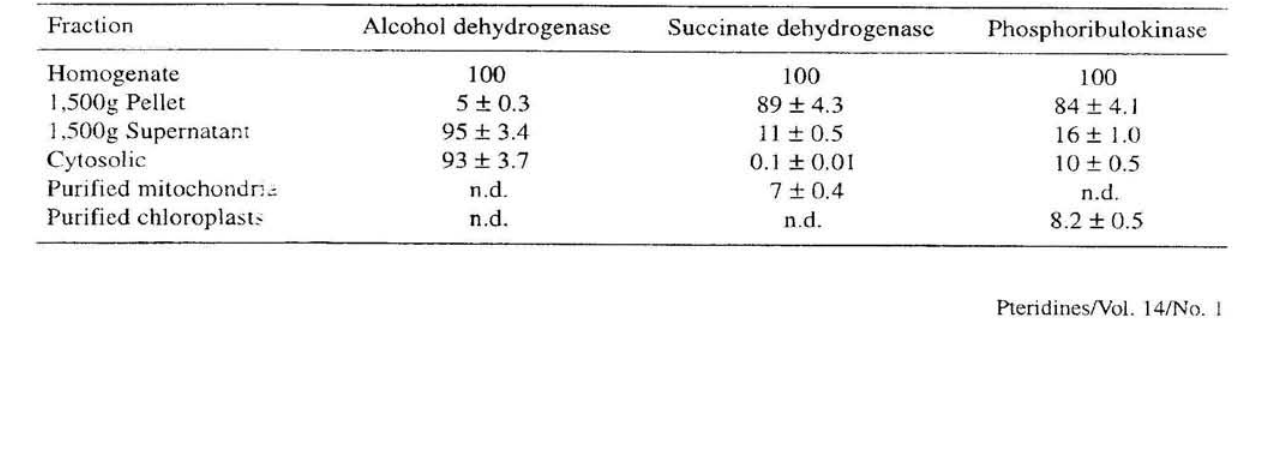
Table 3. Distribution of marker enzymes in subcellular